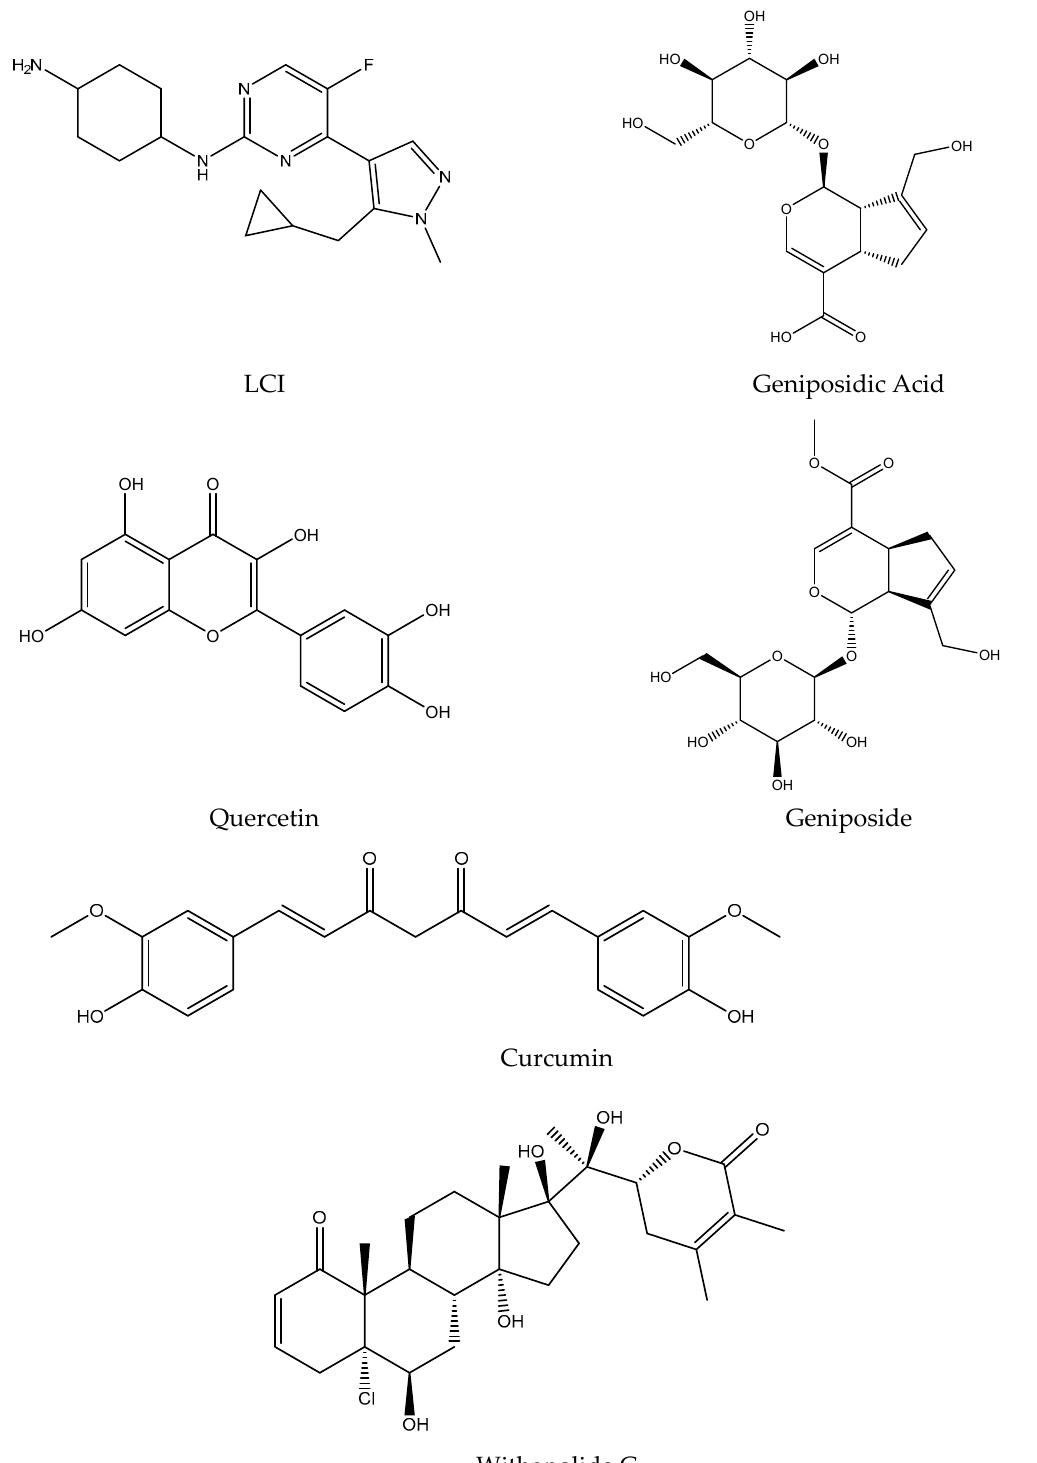
Figure 2. The chemical structures of LCI (PubChem CID: 134812748), geniposidic acid (PubChem CID: 443354), quercetin (PubChem CID: 5280343), geniposide (PubChem CID: 107848), curcumin (PubChem CID: 969516), and withanolide C (PubChem CID: 101559583). The chemical structures were drawn when considering the canonical SMILES and the isomeric SMILES obtained from the PubChem